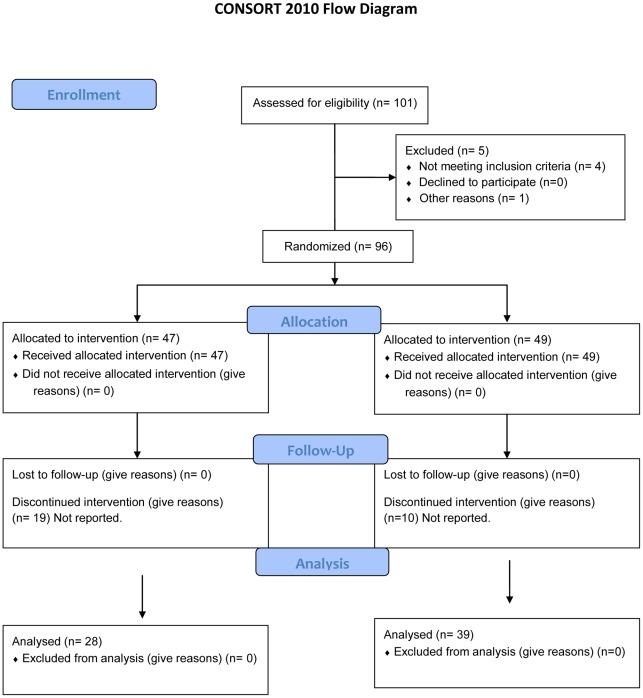
CONSORT 2010 flow diagram.